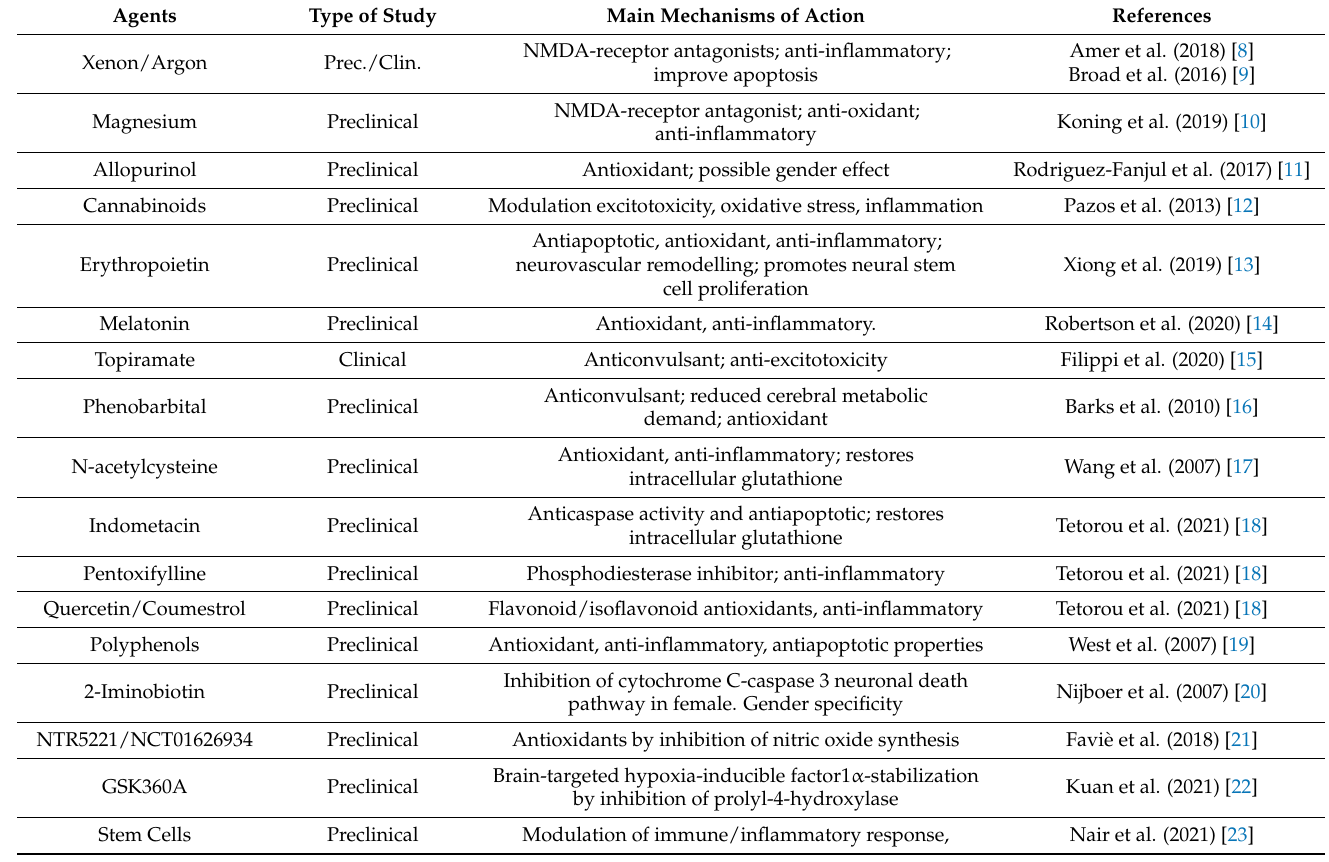
Table 1. Types of Neuroprotective Agents Suggested for Neonatal